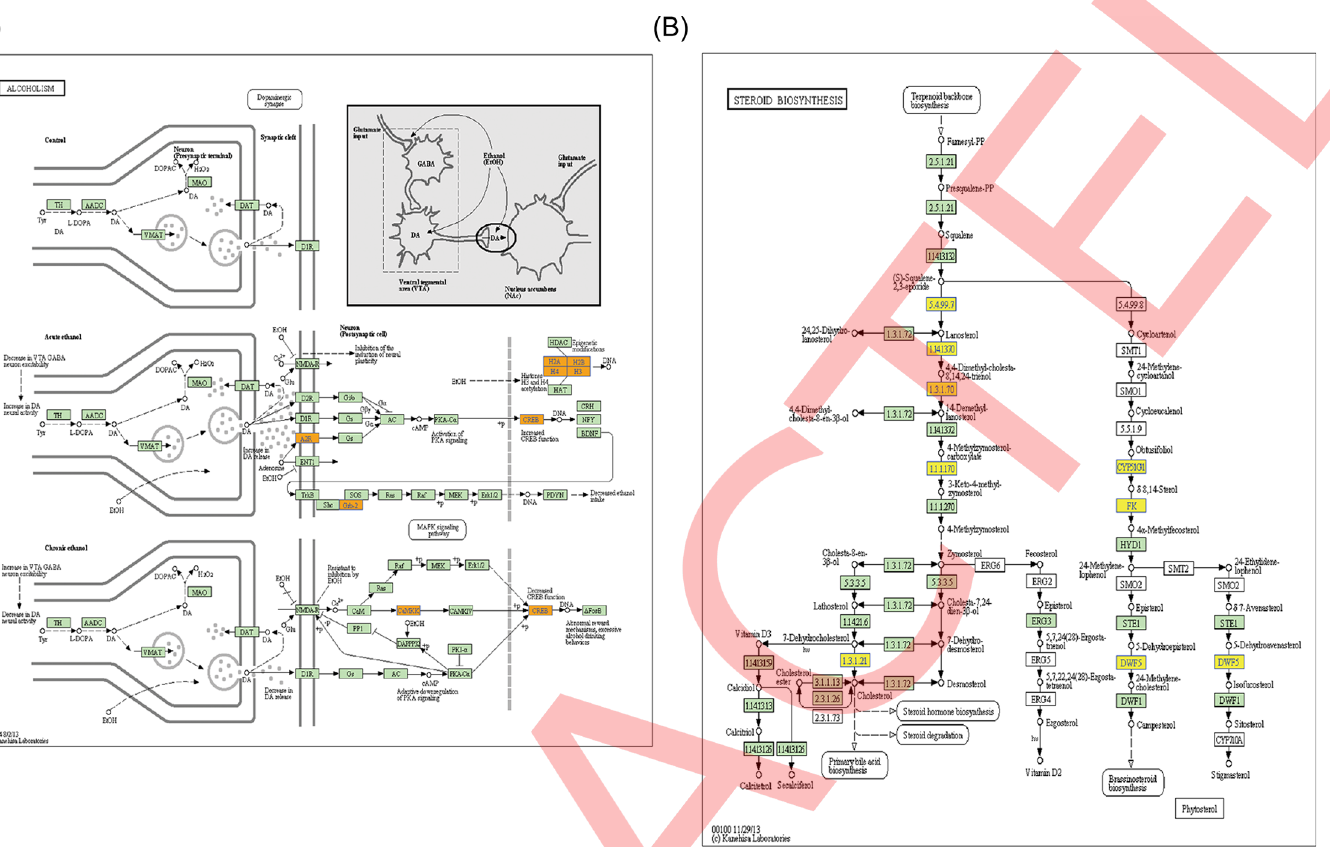
Fig 4. Representational pathway schematic diagrams. (A) Pathway: Alcoholism — Homo sapiens (human). (B) Pathway: Steroid biosynthesis — Homo sapiens (human).The bar plot shows the top ten Enrichment score (-log10 (P value)) value of the significant enrichment pathway. Yellow marked nodes are associated with down-regulated genes, orange marked nodes are associated with up-regulated or only whole dataset genes, green nodes have no significance.